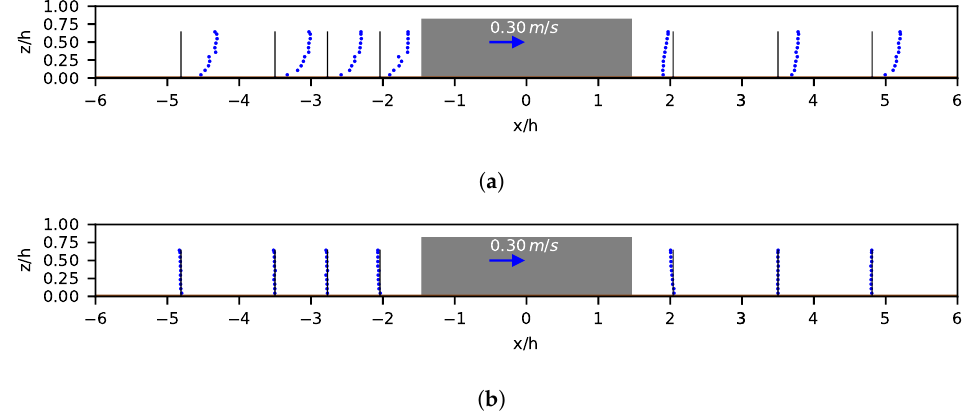
Figure 8. Vertical profiles of the velocity components along the pier’s mid-plane for Exp . 1 D Fbed . ( a ) Stream-wise component of velocity ( u ). ( b ) Vertical component of velocity ( w